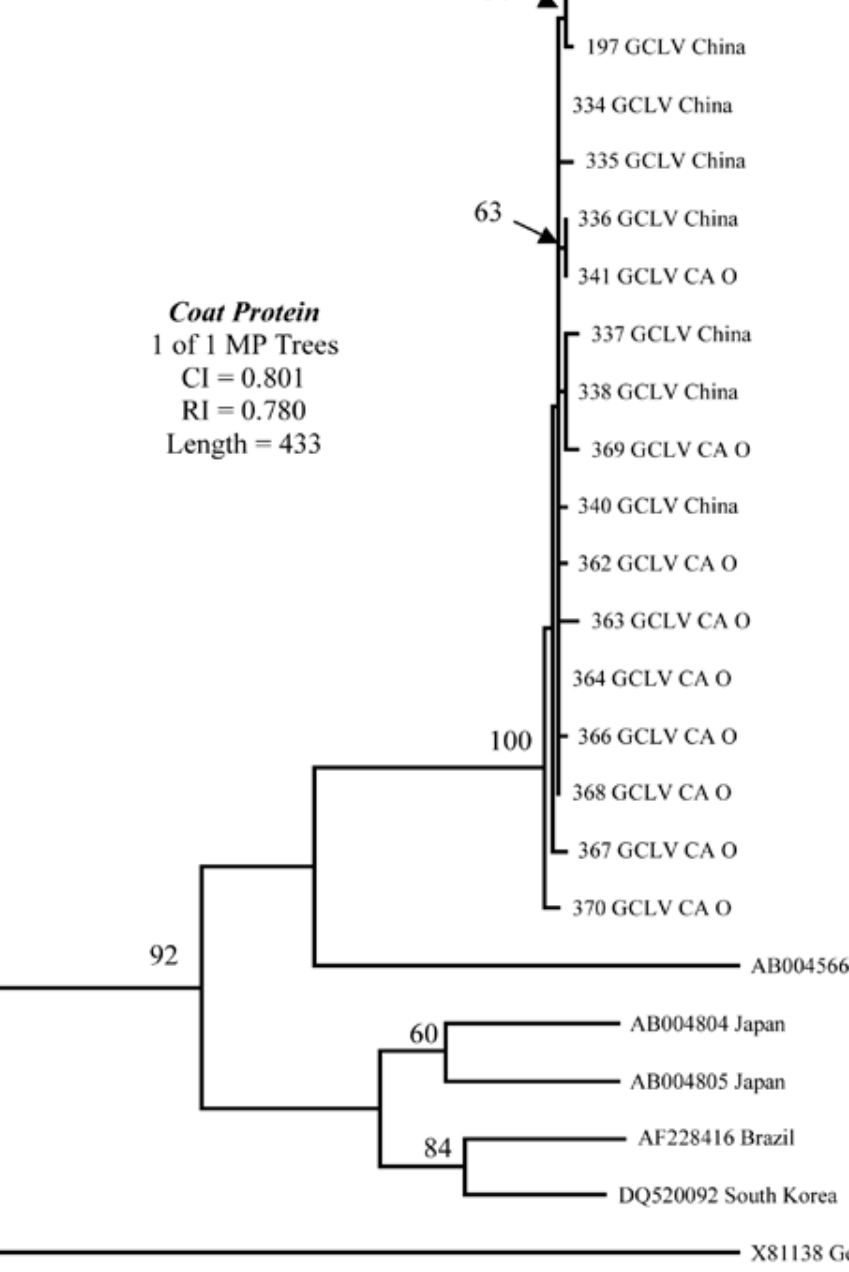
Figure 6. Maximum parsimony analyses of the coat protein gene for Garlic common latent virus (GCLV) isolates obtained in this study as well as sequences from GenBank. Bootstrap support of 50% and above is indicated above nodes based on 1,000 replicates. 195-370: Serial numbering of GCLV cDNA clones, CA: California, and O: Organic. Sequences have